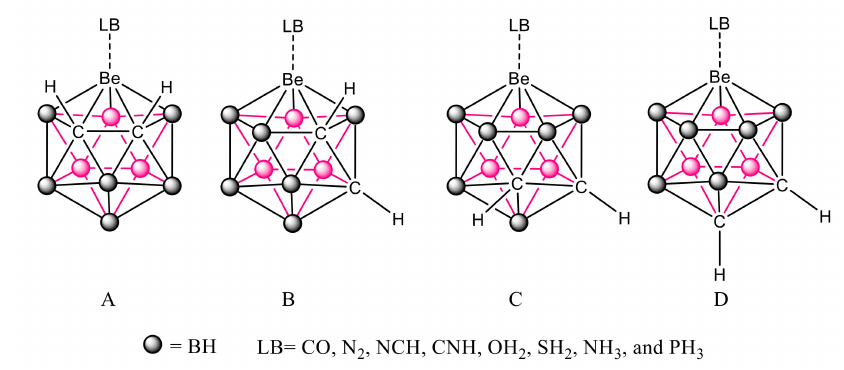
Figure 2. Schematic representation of the complexes between the four beryl-dicarbacloso-dodecaborane isomers ( A – D ) and the Lewis Bases considered in the